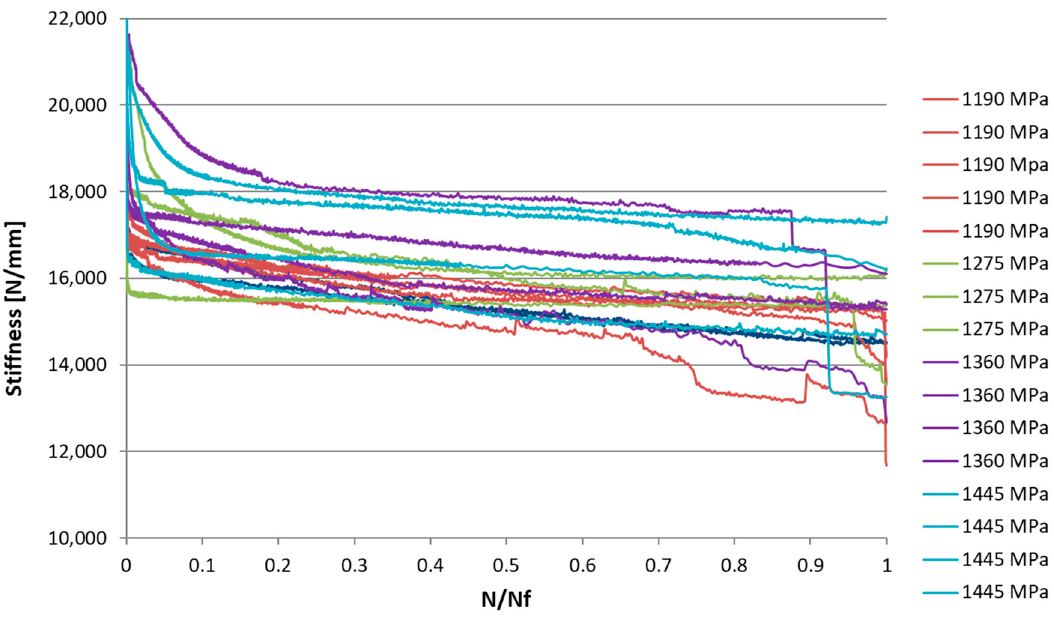
Figure 3. Stiffness trend as a function of the normalized number of cycles.